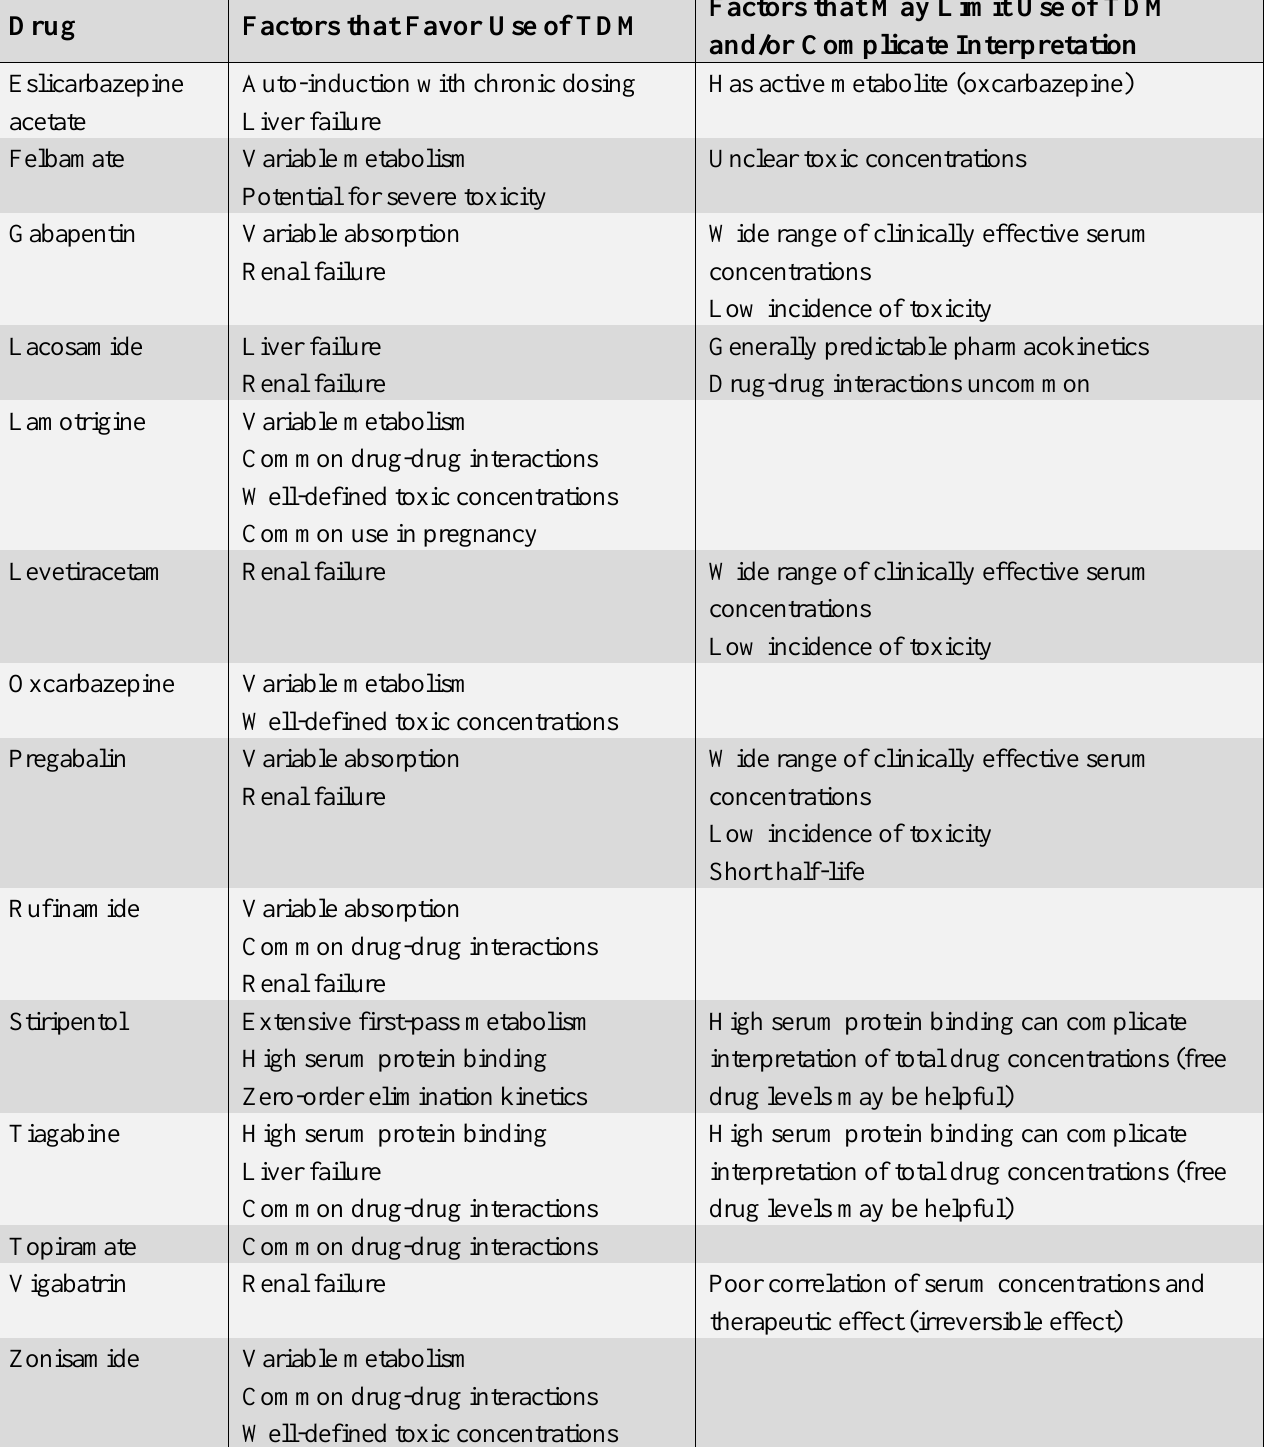
Table 2. Summary of factors that influence use and interpretation of TDM for newer